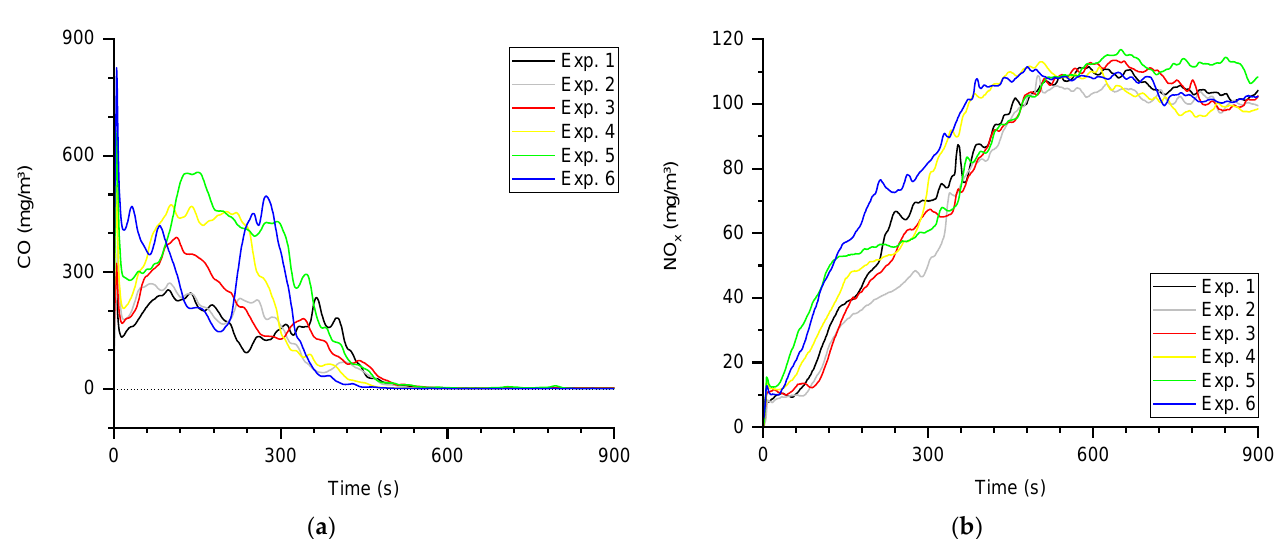
Figure 7. Gaseous emissions content in the flue gas for the start-up phase; ( a ) CO and ( b ) NO x for standardized 13 vol. % O 2 content in dry flue gas (STP).